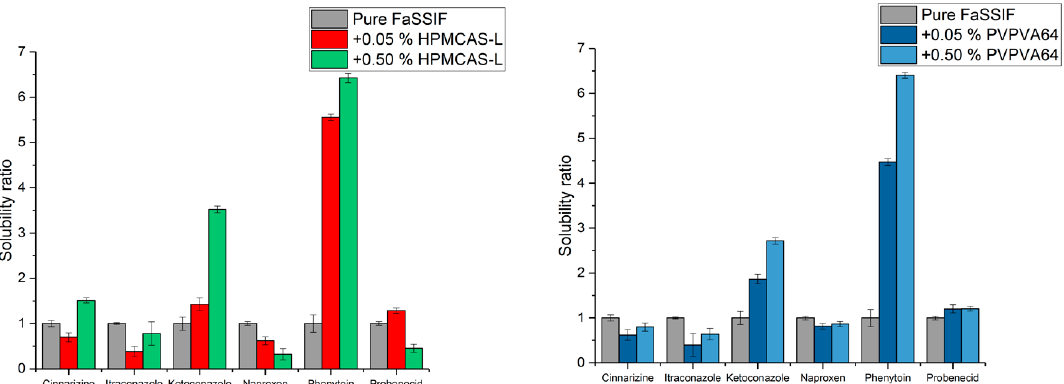
Figure 1. Solubility ratio of the model drugs in fasted state simulated intestinal fluid (FaSSIF) with hypromellose acetate succinate L-grade (HPMCAS-L) ( left ) and vinylpyrrolidine-vinyl acetate copolymer (PVPVA64) ( right ) (drug in pure fasted state simulated intestinal fluid (FaSSIF) is given a ratio of 1). Table 2. Solubility of the investigated drugs in fasted state simulated intestinal fluid